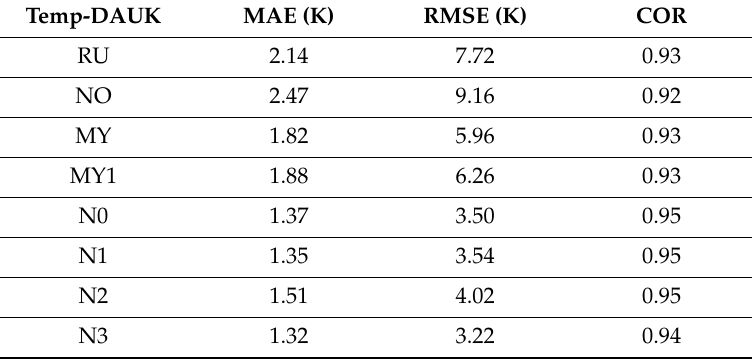
Table A4. Mean absolute error (MAE), root mean square error (RMSE), and correlation coe ffi cient (COR) for surface temperature (Temp) at Touggourt Sidi Mahd (Algeria); meteorological aviation reporting (METAR) station code = DAUK.